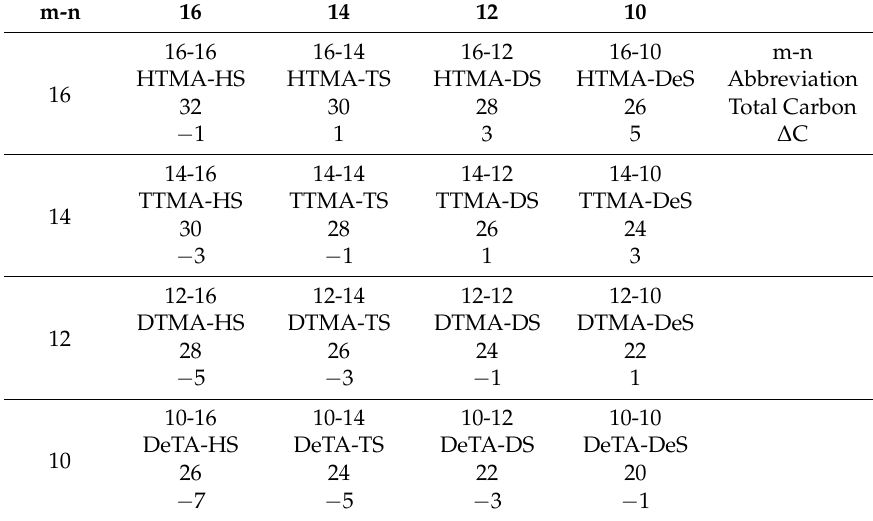
Table 1. Combination of alkyltrimethylammonium–alkylsulfate IPA systems, i.e., C m TMA + -C n S − , with m and n valued from 16 to 10. The surfactant abbreviations, the total alkyl carbon number, and the asymmetry index ∆ C (Equation (1)) are also